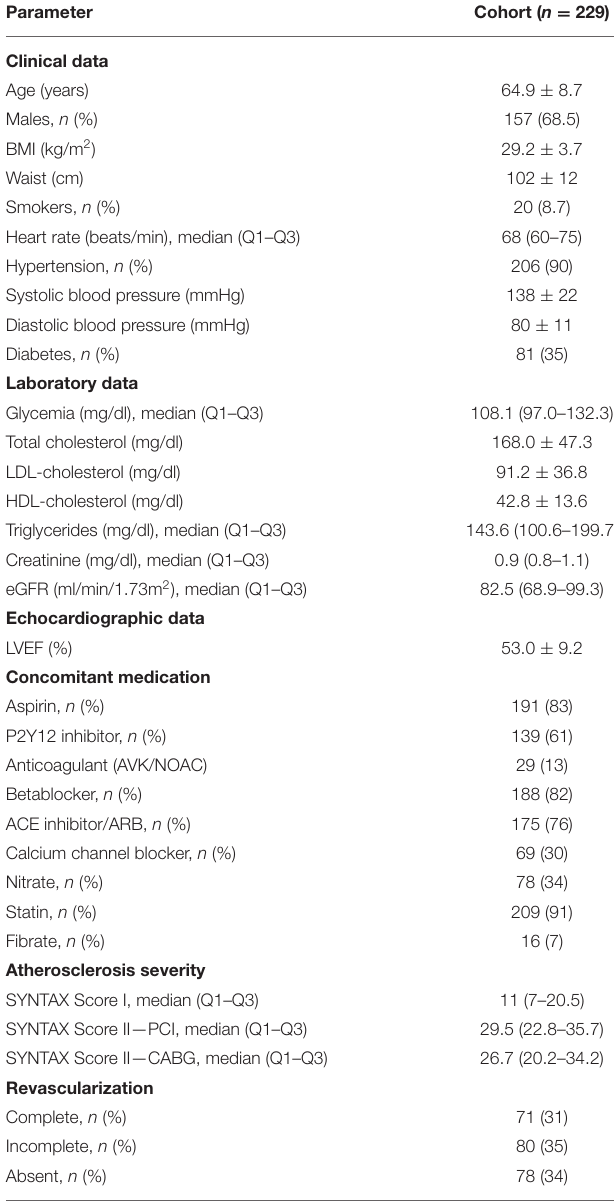
TABLE 1 | Baseline patient characteristics in the study